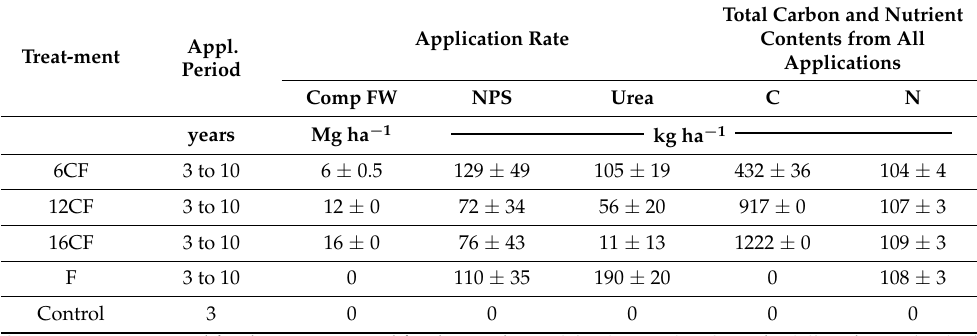
Table 1. Application period, rates, carbon and nitrogen contents of compost, and mineral fertilizer for maize; n = 4 replicates for each treatment (means ± SD). Treat- Appl. ment Period